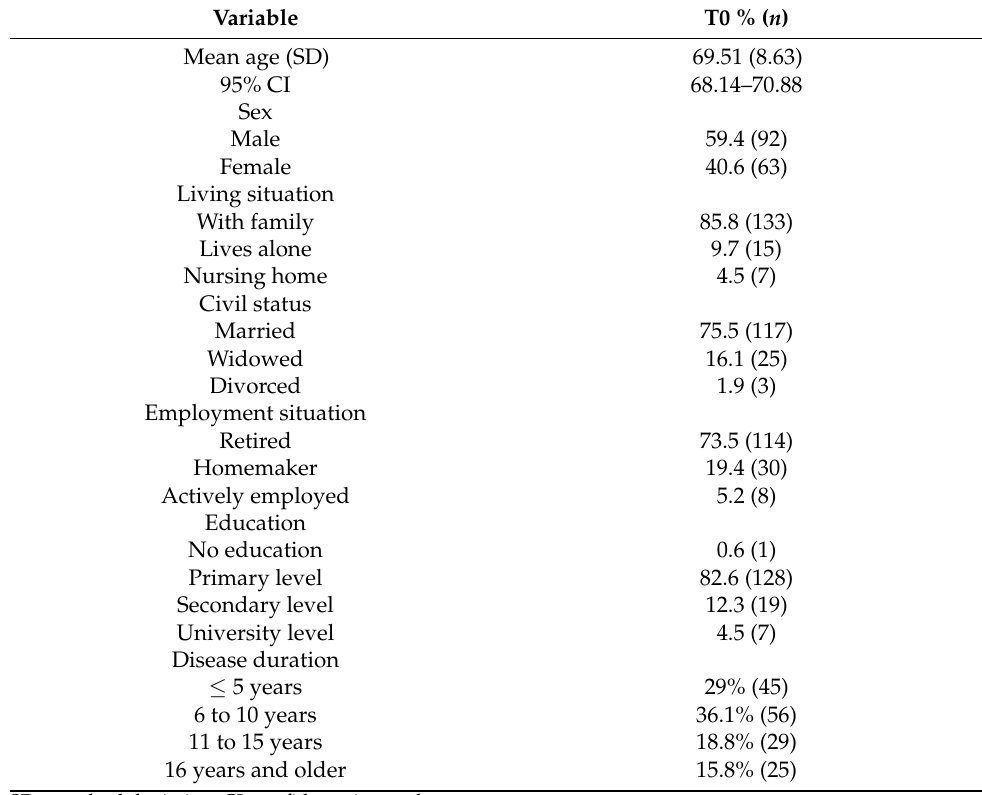
Table 1. Sociodemographic and clinical characteristics of the study sample.